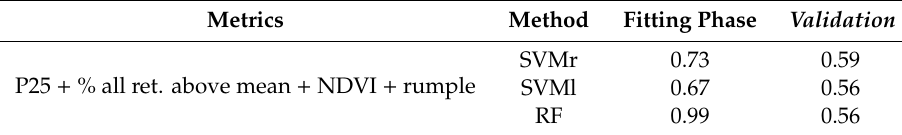
Table 4. Comparison between classification methods using overall accuracy for the four selected metrics when combining ALS and Sentinel 2 metrics.